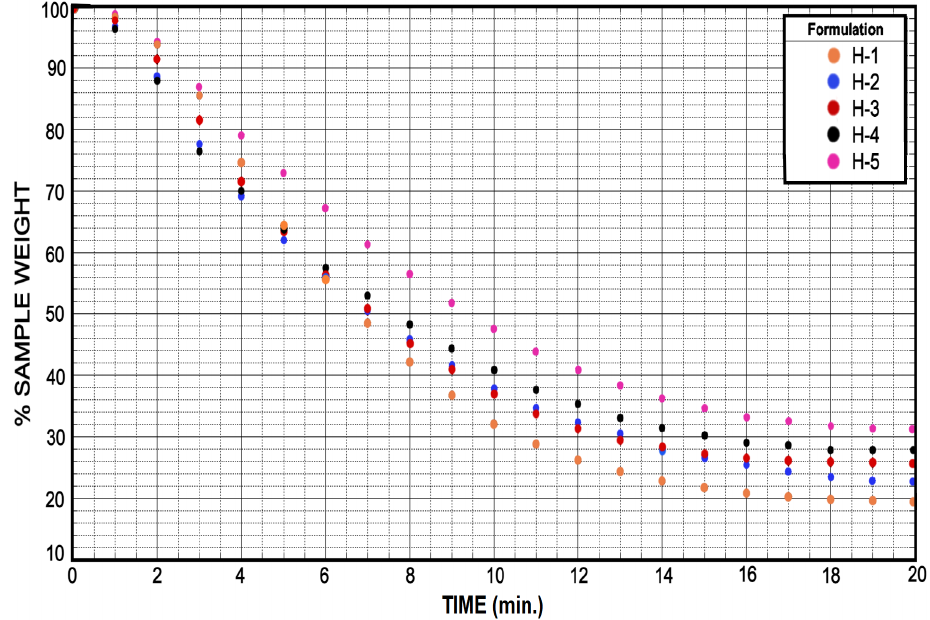
Figure 14. The drying test showed a marked relationship in the behavior of the five samples for the release of the liquid retained in the hydrogel. This guarantees zero interference by the cross-linking agent (PEGDA) in processes involving the discharge of